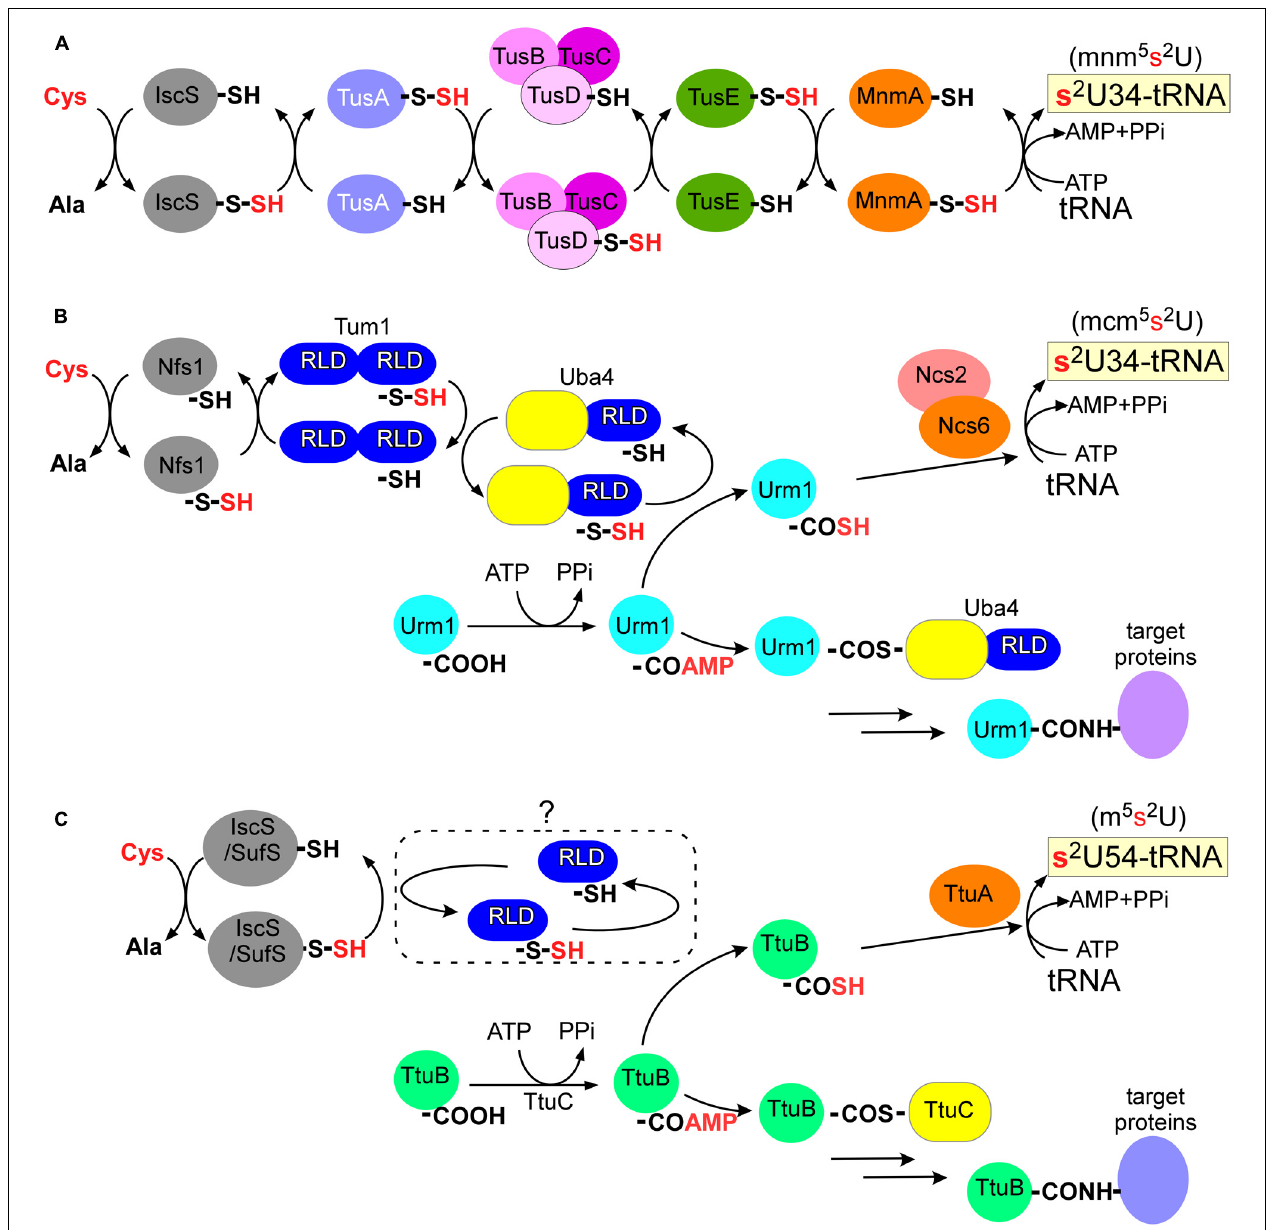
FIGURE 3 | Biosynthesis pathway of 2-thiouridine derivatives. (A) In E. coli , Tus proteins relay the persulfide sulfur of IscS to a modification enzyme, MnmA. (B) In S. cerevisiae , Urm1 acts both as sulfur carrier and protein modifier. A thioester conjugate or an acyldisulfide conjugate (not